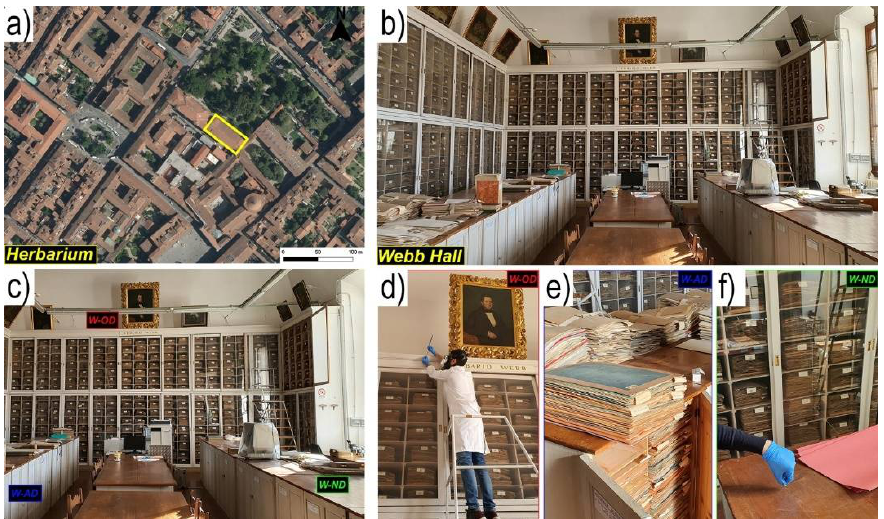
Figure 1. ( a ) Geographical location of the Central Italian Herbarium (Florence, Italy); ( b ) the Webb Hall ; ( c ) detail location of the sampling points in the Webb Hall for the different dust types: ( d ) old-dust (W-OD), ( e ) almost-new dust (W-AD), and ( f ) new-dust (W-ND).